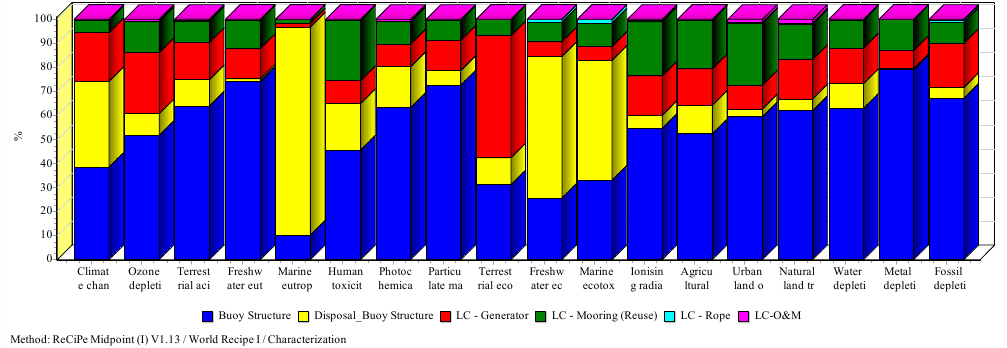
Figure 3. Life cycle impact of BRD WEC.